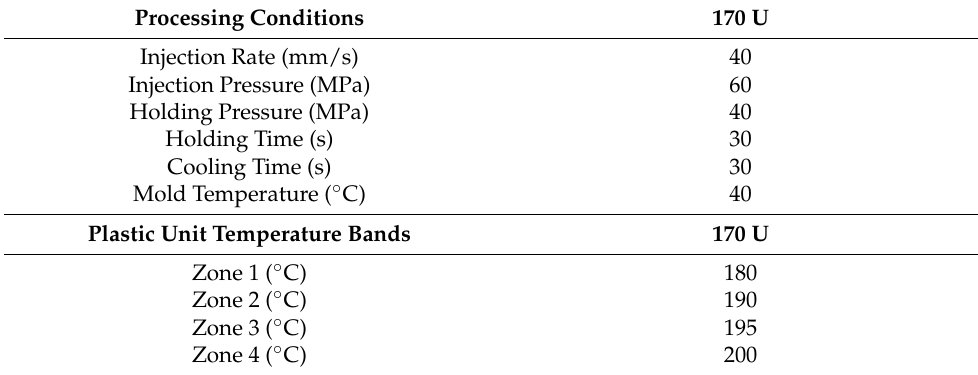
Table 1. Injection molding